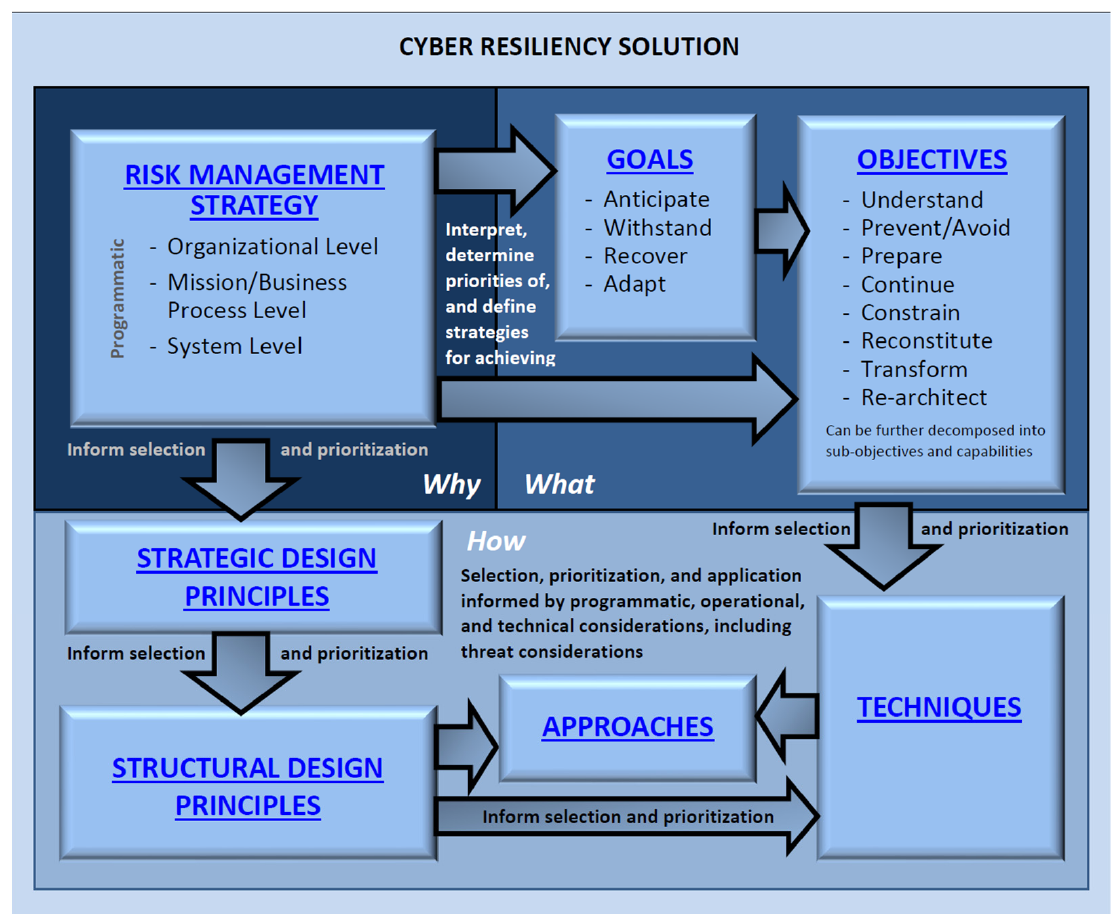
Figure 1. Top ‐ level view of NIST Cyber Resiliency Framework [22]. Figure 1. Top-level view of NIST Cyber Resiliency Framework